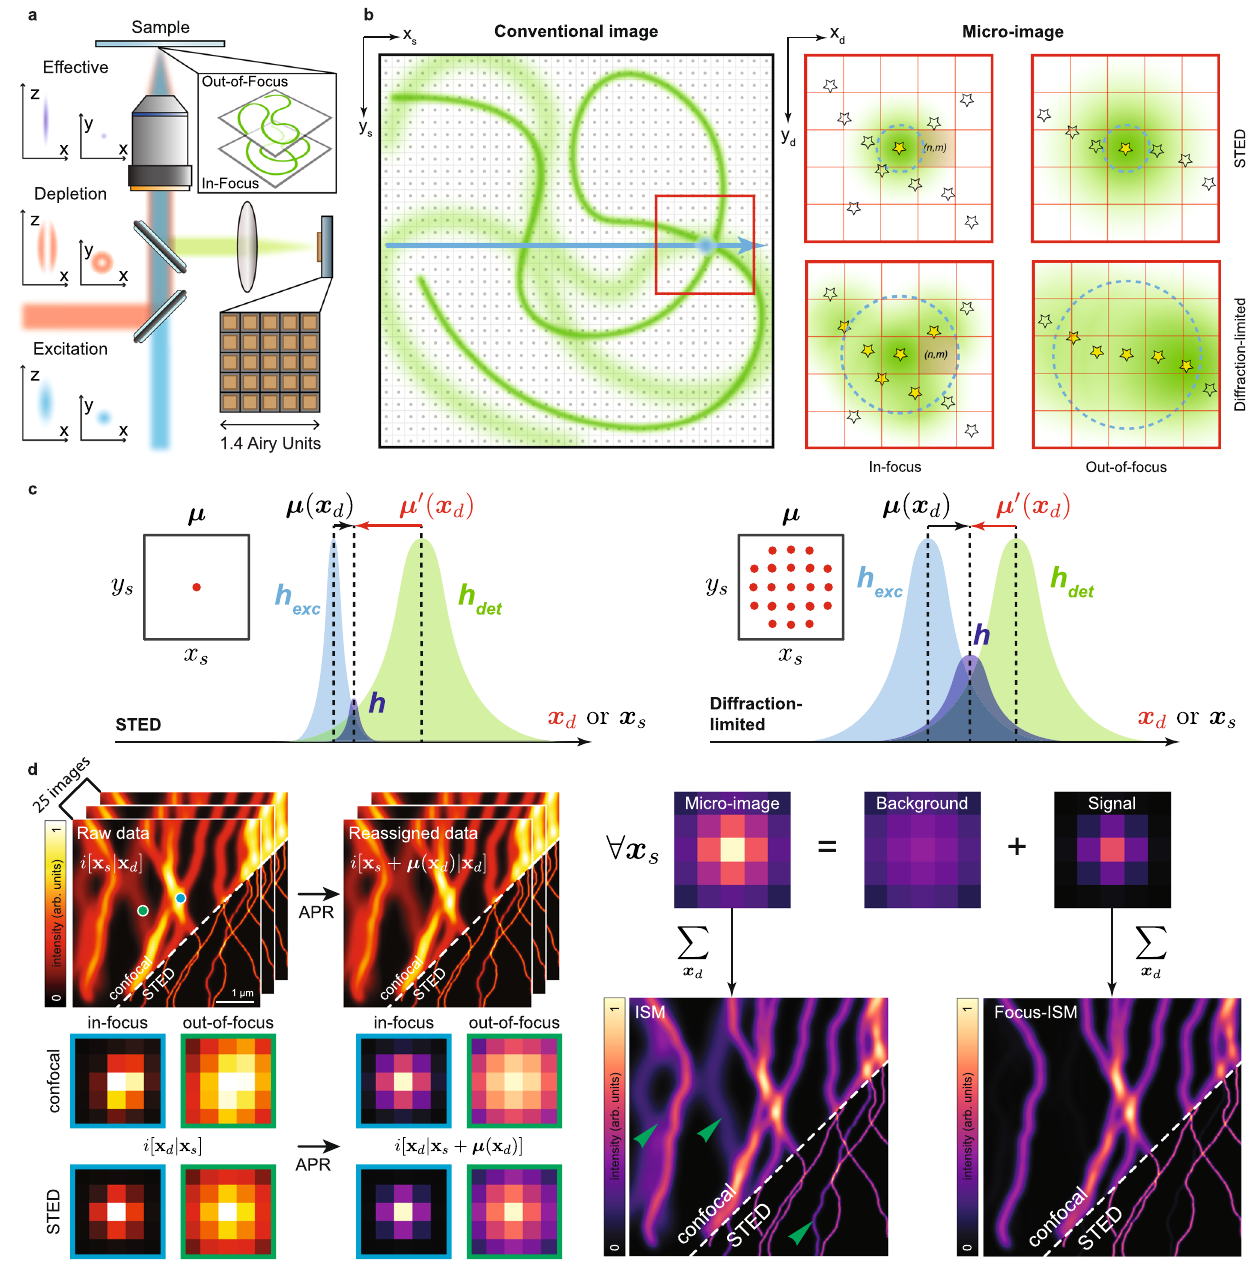
Fig.1|Focus-ISMimaging. In( a ),wepresentasketchoftheSTED-ISMmicroscope, equipped with a 5×5 detector array. In ( b ), we present a sketch of the image formation process in our setup. The sample — represented with an in-focus (sharp) and an out-of-focus (blurred) component — is raster scanned with the excitation beam. Each scan point (dark square) is related to a micro-image of the illuminated region (red square). The blue circleand the green halo represent, respectively, the excitationPSFandtheemissionoftheexcited fl uorophores(yellowstars).In( c ),we depict the (adaptive) pixel-reassignment concept for a speci fi c detector element ( n , m ). The shift vector μ of a scanned image is the maximum position of